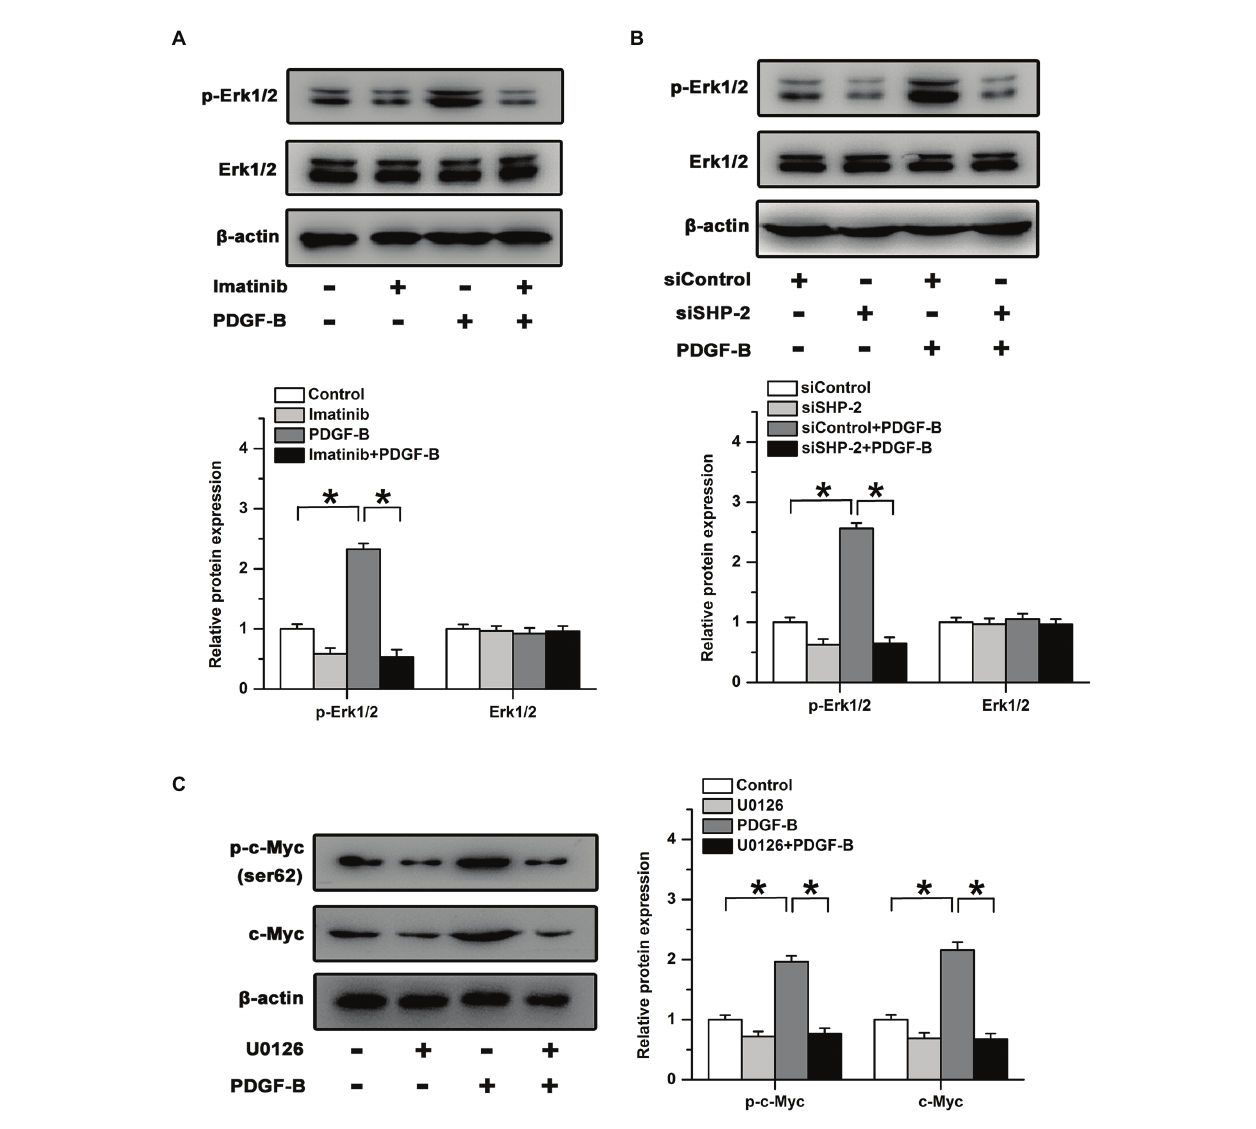
FIGURE 4 | The regulatory effects of PDGF-B on c-Myc expression are mitigated by the inhibition of the Erk pathway. (A) Inhibition of PDGFR mitigated the phosphorylation of Erk induced by PDGF-B. (B) The phosphorylation of Erk increased by PDGF-B was attenuated by knockdown of SHP-2. (C) The increased expression and phosphorylation of c-Myc induced by PDGF-B were mitigated by U0126. *indicates p <